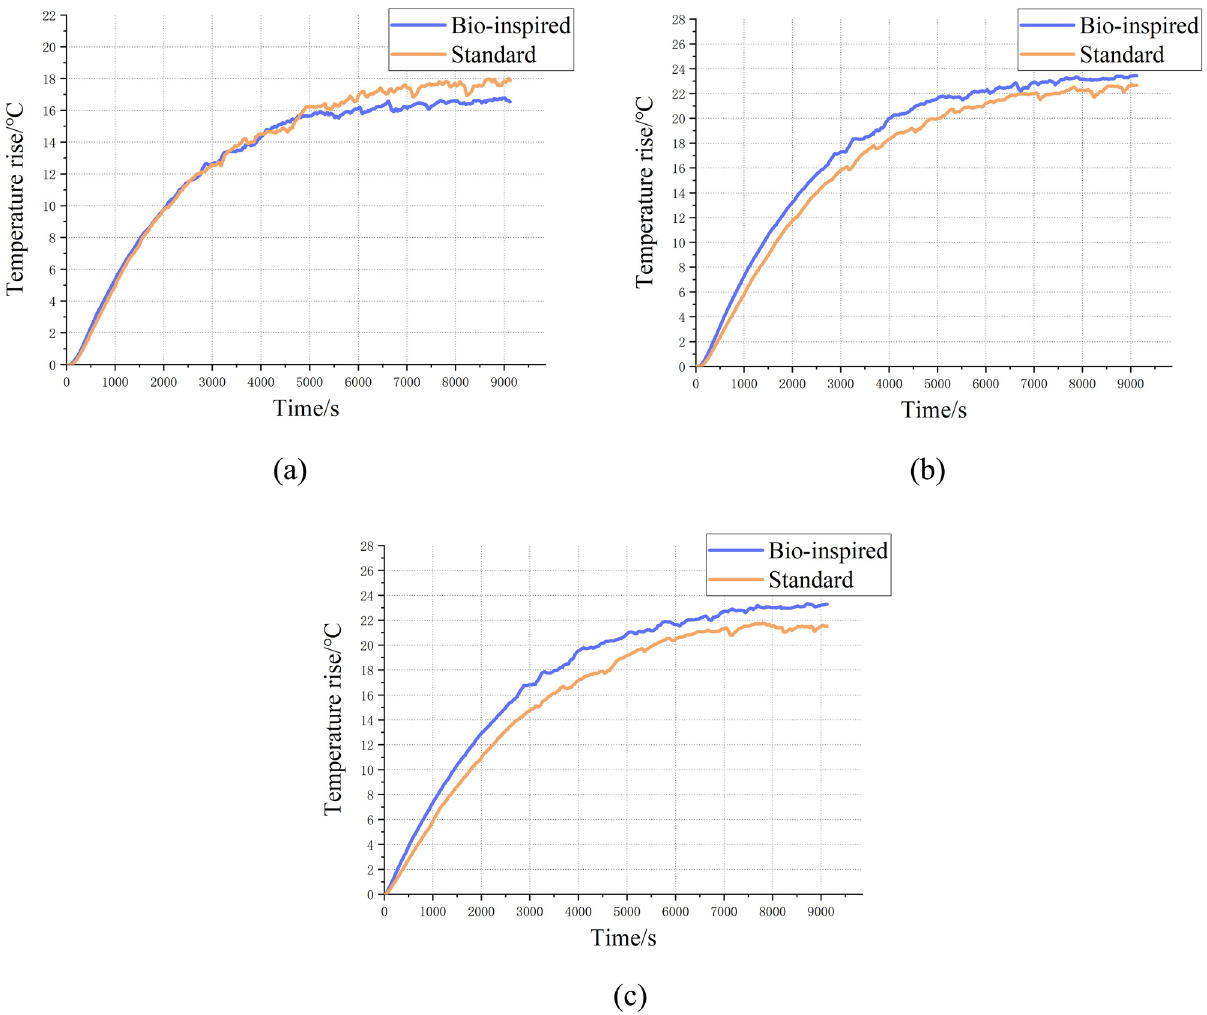
Figure 10: Comparison of temperature rise at various points for the 25 V supply voltage: ( a ) point T1; ( b ) point T2; ( c ) point